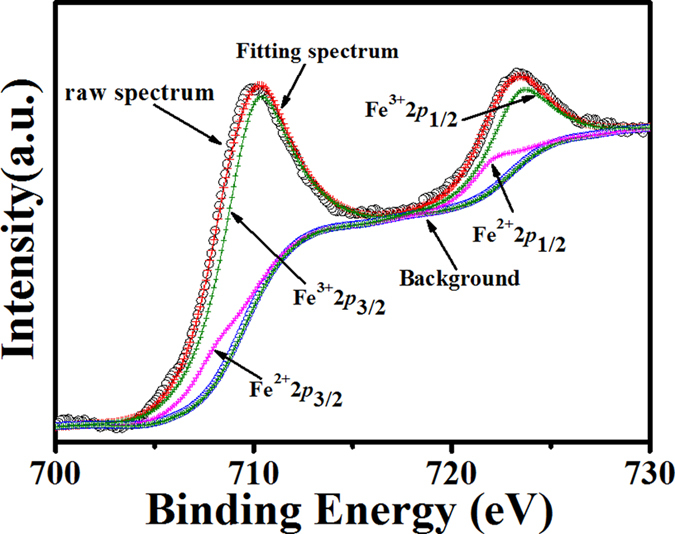
The representative XPS spectra of iron ions for LaFe12O19 sample.